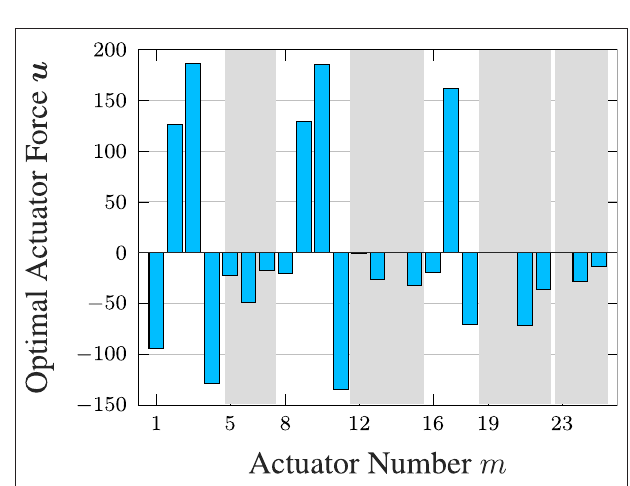
FIGURE 7 | Calculated optimal actuator forces for each actuator. Serial actuators are marked by a gray